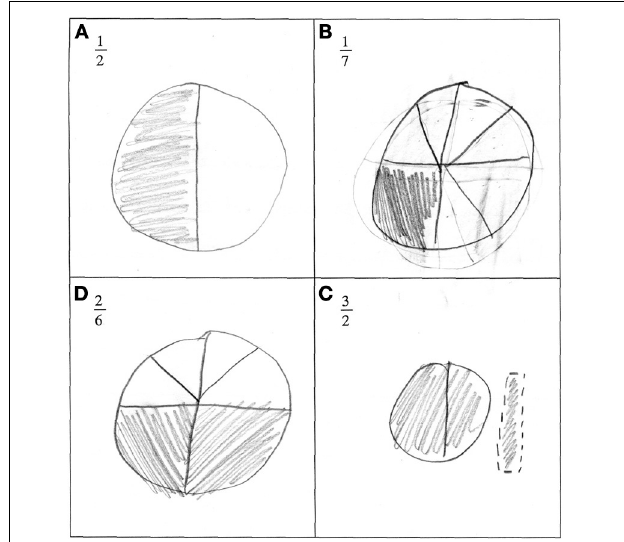
FIGURE 3 | Illustration of the most common answer when pupils were asked to draw a representation of a given fraction. 90% of